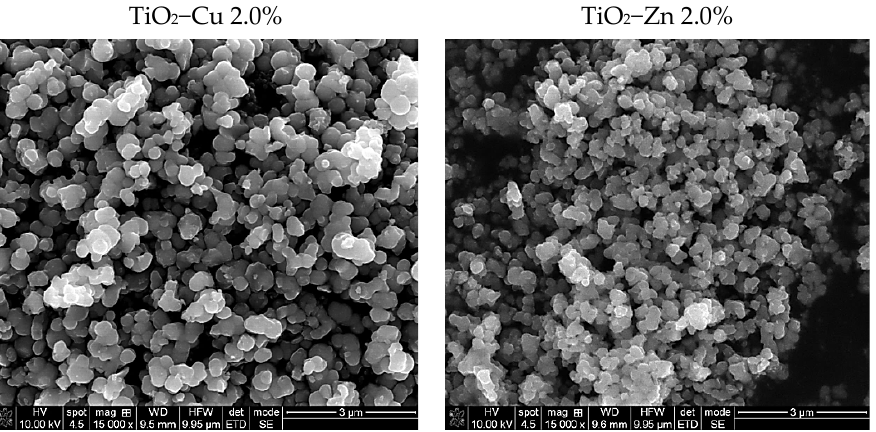
Figure 3. SEM micrographs of the as − prepared